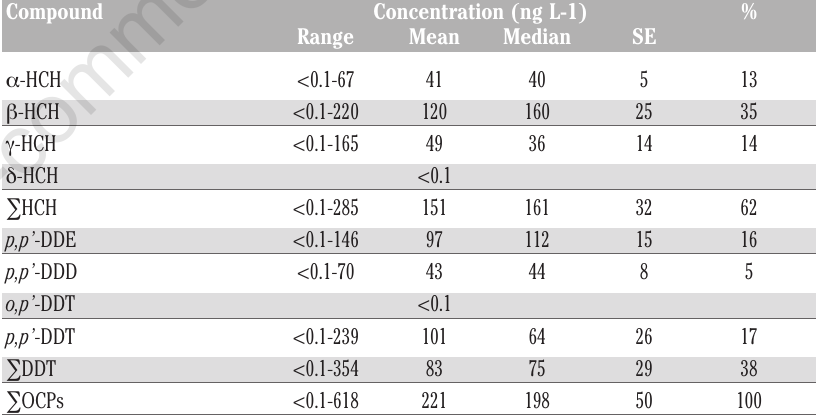
Table 4. Concentration of organochlorine pesticides in Yamuna River water.